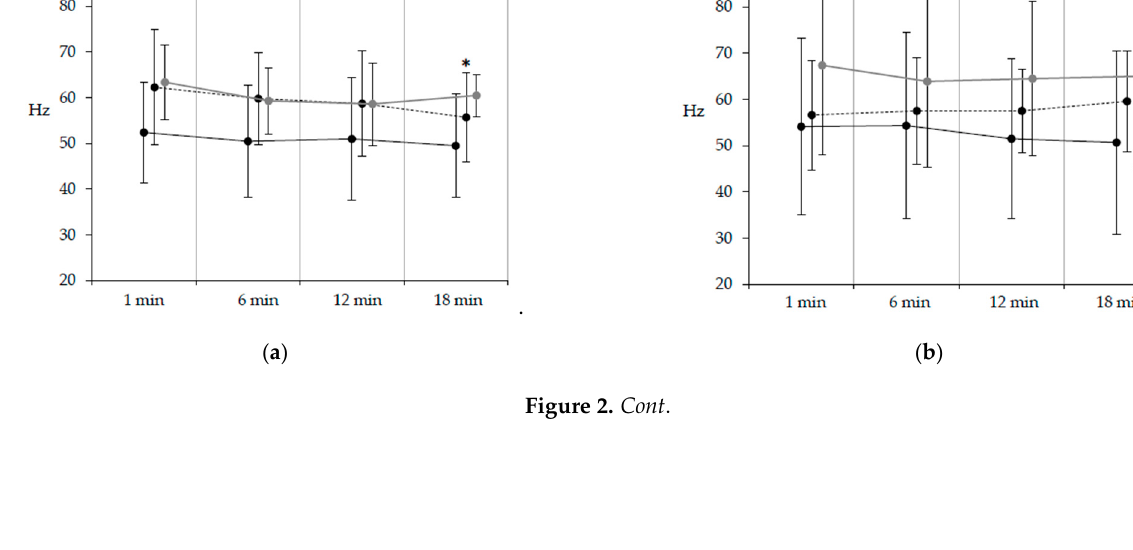
( d ) Figure 2. Temporal changes in the instantaneous mean frequency (IMNF) during the extended walking test. Values are expressed as mean (standard deviation). ( a ) Tibialis anterior; ( b ) Soleus; ( c ) Rectus femoris; ( d ) Biceps femoris. The solid line represents the paretic side, the dotted line represents the nonparetic side, and the gray line represents healthy subjects. The IMNF of the tibialis anterior on the nonparetic side significantly decreased at 18 min compared with that at 1 min. The IMNF of the rectus femoris on the paretic side significantly decreased at 6 min and 18 min compared with that at 1 min. 4. Discussion The physical characteristics of the subjects with stroke in this study consisted of mild to moderate movement disorders, muscle weakness, and spasticity. In the subjects with stroke, the gait velocity and stride length increased after 20 min from the start of walking; however, other gait parameters did not change over time. The EMG amplitude decreased in the tibialis anterior during the pre-swing phase and increased in the rectus femoris during the single-support phase, these changes being similar on the paretic and nonpa- retic sides. Meanwhile, a downward shift in EMG frequency was observed only in the nonparetic side tibialis anterior and only in the paretic side rectus femoris. All the data for the healthy subjects remained unchanged over time. In a previous study [4], walking performance decreased during the 6MWT, but in this study, walking performance was maintained despite a longer walking time. For the subjects with hemiplegia, the change in walking time from 6 to 18 min represented a shift from light to hard physical exertion [5]. It is probable that the subjects in this study expe- rienced fatigue because RPE increased over time. Nevertheless, HR was stable after 6 min and walking performance was maintained. The increase in RPE may be attributable to the presence of stroke-specific impairments (e.g., muscle weakness or spasticity) [33]. The